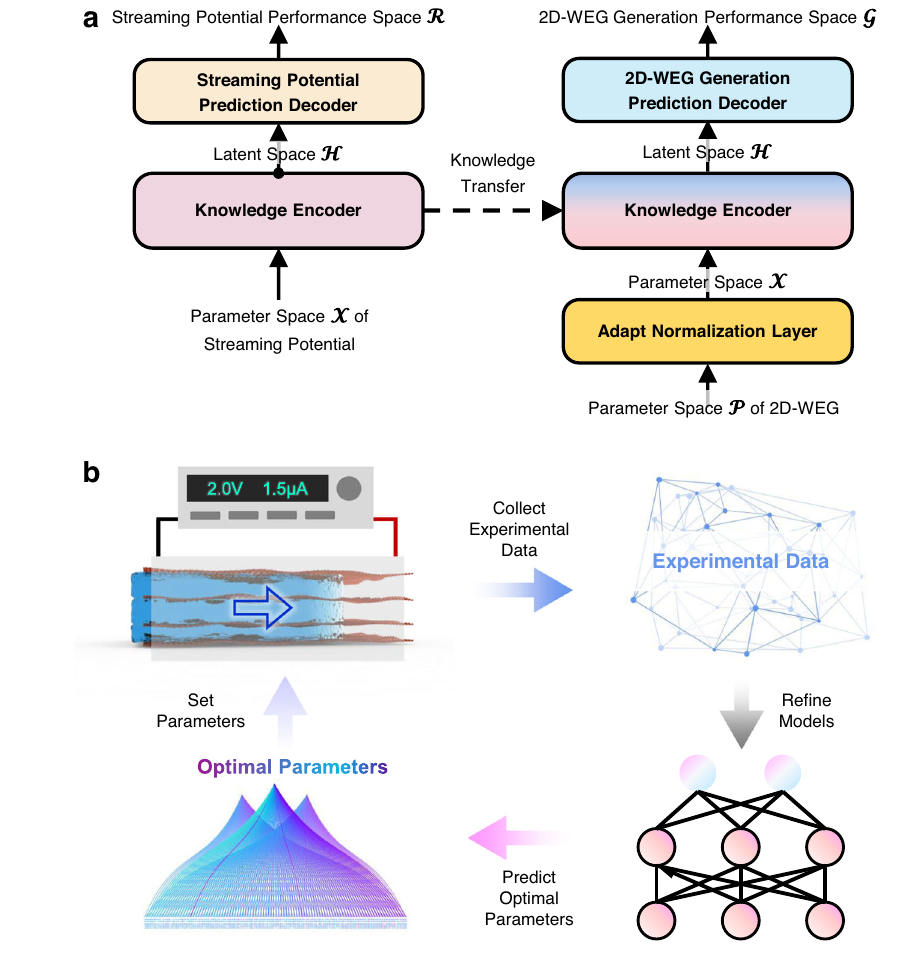
Fig. 4 | TL framework and iterative optimization strategy. a Schematic illustra- tion of the TL framework. A source model with an encoder-decoder architecture was fi rsttrainedusingstreamingpotentialdata.Then,theEncoderistransferredto the opt-model to initialize the parameters, and the experimental data are used to train decoding predictions from the latent space to 2D-WEGs performance. b Schematic illustration of the iterative optimization process. Initially, the